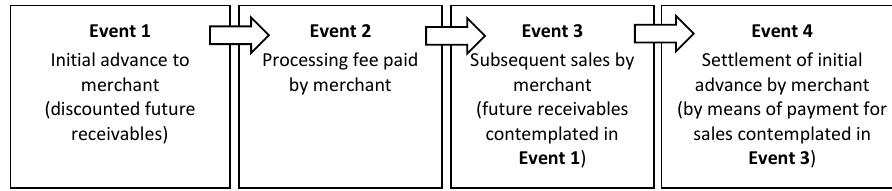
FIGURE 1: Relevant events in an MCA